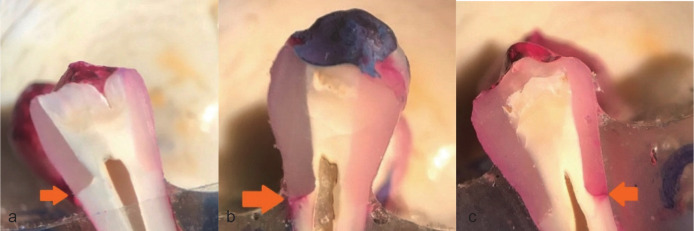
 The picture of sectioned samples under stereomicroscope, a; no dye penetration, b; dye penetration more than ½ of the gingival wall, which does not reach the axial wall, c;dye penetration along the axial wall